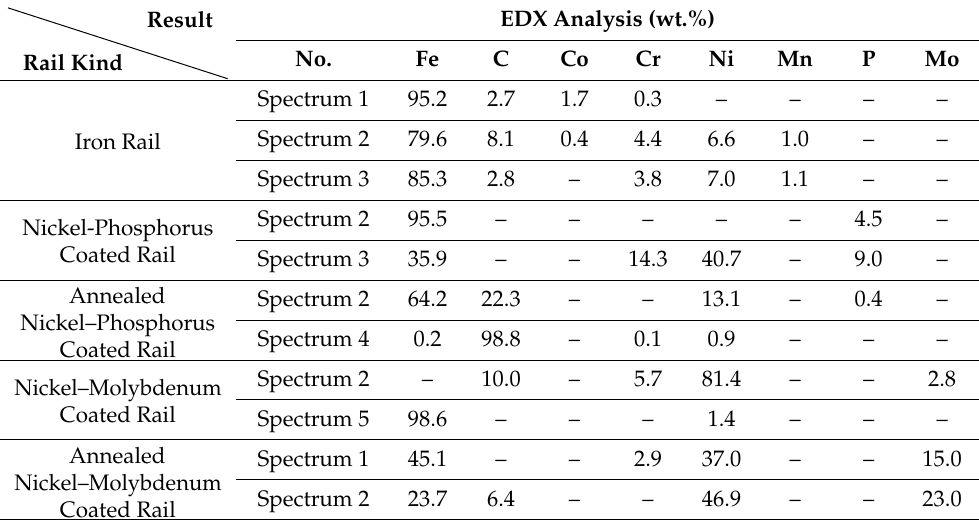
Table 5, the EDS analysis of spectrum 2 revealed that Fe (95.5 wt.%) is the major element. It looks like the third substance, then transferred to and covered the surface of nickel–phosphorus-coated rail; Ni (40.7 wt.%) and Fe (35.9 wt.%), represents major elements in the spectrum 3 region, indicating